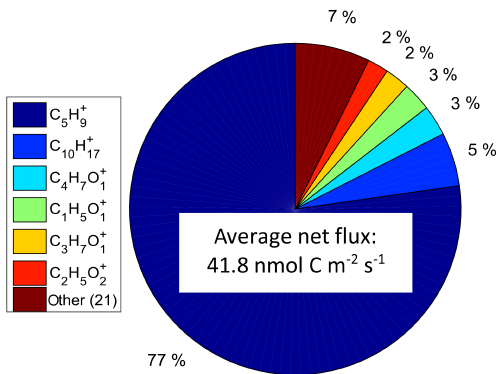
Figure 6. Average net flux of the major carbon emitters. Two masses were disregarded, as no matching elemental composition was